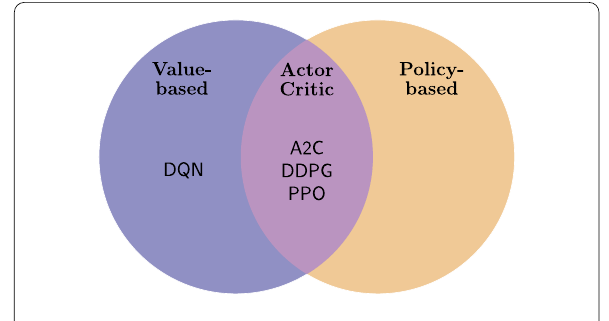
Figure 3 Taxonomy of RL